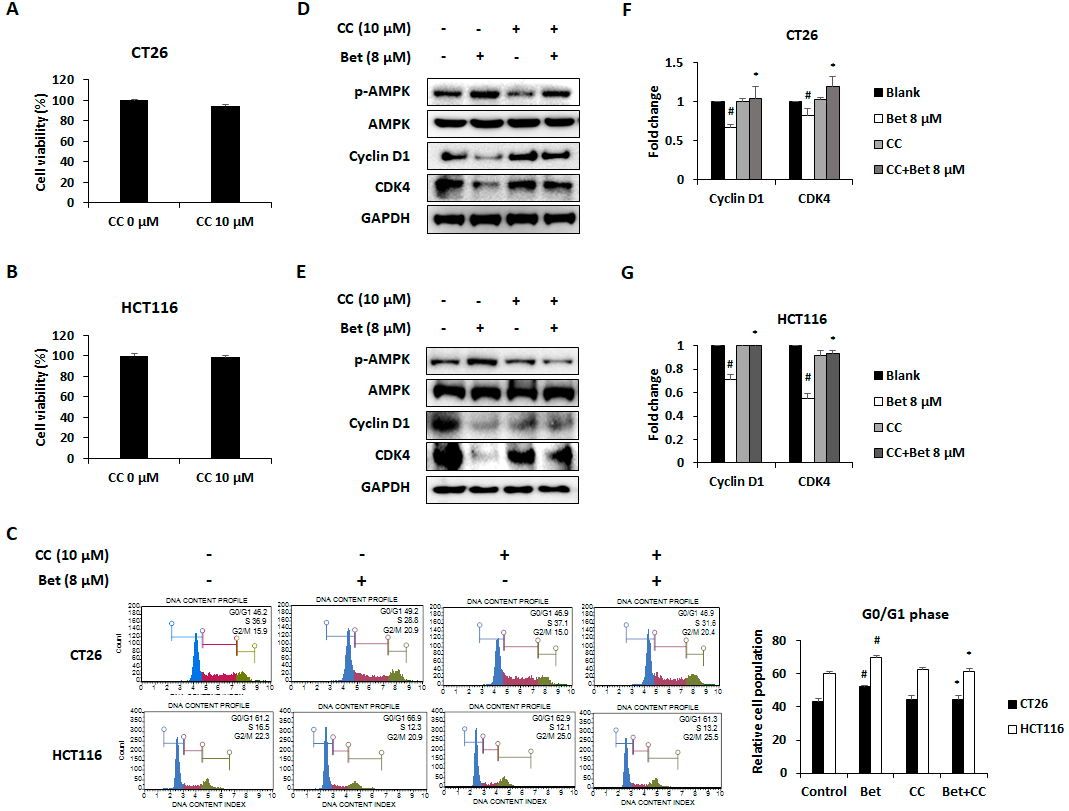
Figure 3. G0 / G1 phase arrest by betulin in metastatic colorectal cancer cells is mediated via AMPK activation. Cell viability of CT26 ( A ) and HCT116 ( B ) cells after compound C (CC) treatment for 24 h. ( C ) Changes of cell cycle phase in betulin-treated CT26 and HCT116 cells by CC treatment. Images represent three independent experiments. AMPK phosphorylation and protein expression of cyclin D1 and CDK4 were determined in betulin and CC-treated CT26 ( D ) and HCT116 ( E ) cells. mRNA expression levels of cyclin D1 and CDK4 in CT26 ( F ) and HCT116 ( G ) cells with betulin and CC treatment for 24 h. Data are means ± standard deviation of three independent experiments. # p < 0.05 versus control and * p < 0.05 versus betulin alone.